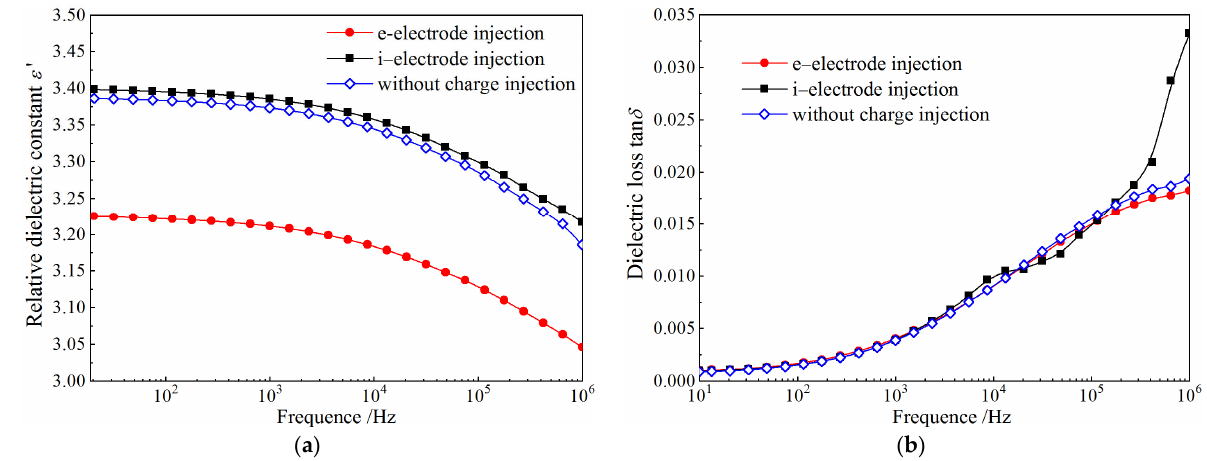
Figure 6. ( a ) Relative dielectric constant and ( b ) dielectric loss for PET film samples after charge injections by applying an electric field of 100 kV/mm individually with e-electrode and i-electrode, compared with the normal sample without charge injection using semiconductor electrode.